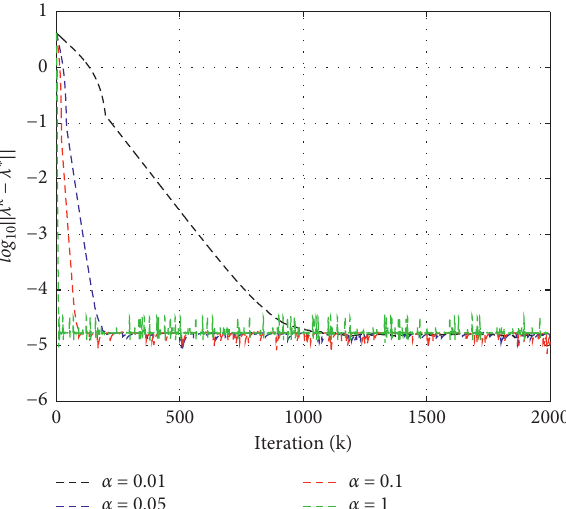
Figure 8: Convergence of log ‖ λ k − λ ∗ ‖ in the subgradient method followed by dual decomposition with different constant step sizes. The 10 figure shows a trade off, large α yields fast